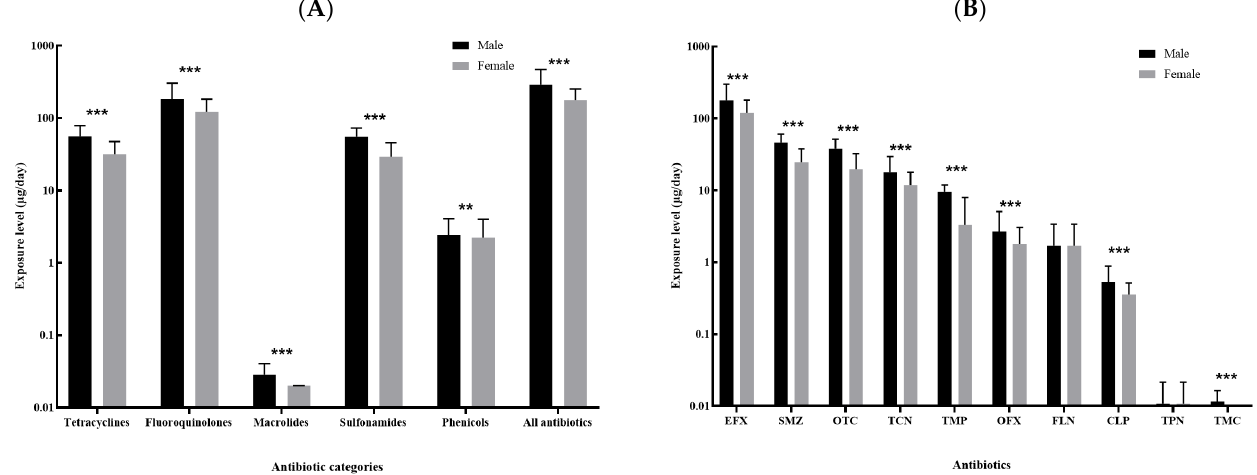
Figure 3. Comparison of the dietary exposure contents to antibiotics between male and female: ( A ).